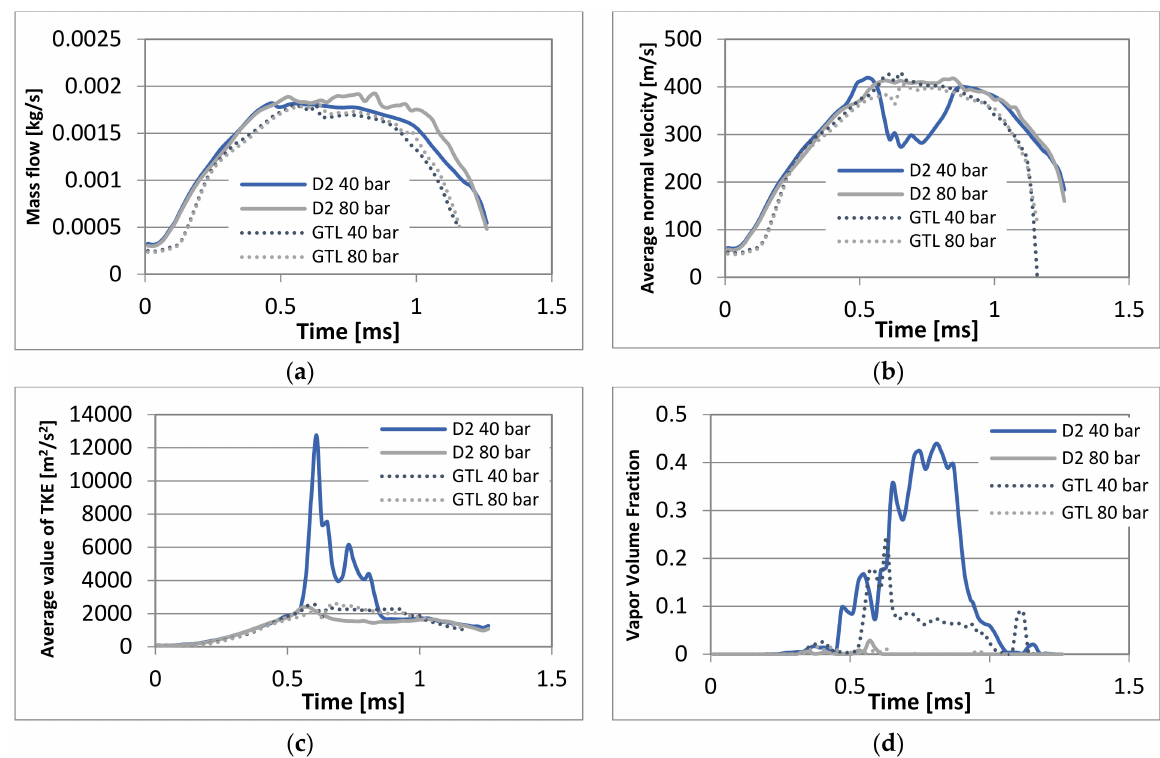
Figure 13. Outlet integral quantities for 1 of the injection hole: ( a ) Mass flow rate; ( b ) Average normal velocity; ( c ) Average 2 value of liquid turbulent kinetic energy; ( d ) Maximal value of Vapor Volume